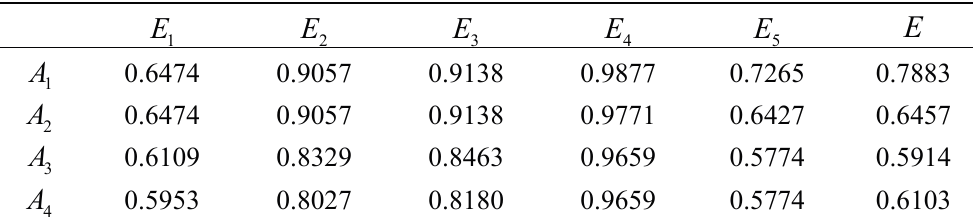
Table 2. Values of the different entropy measures